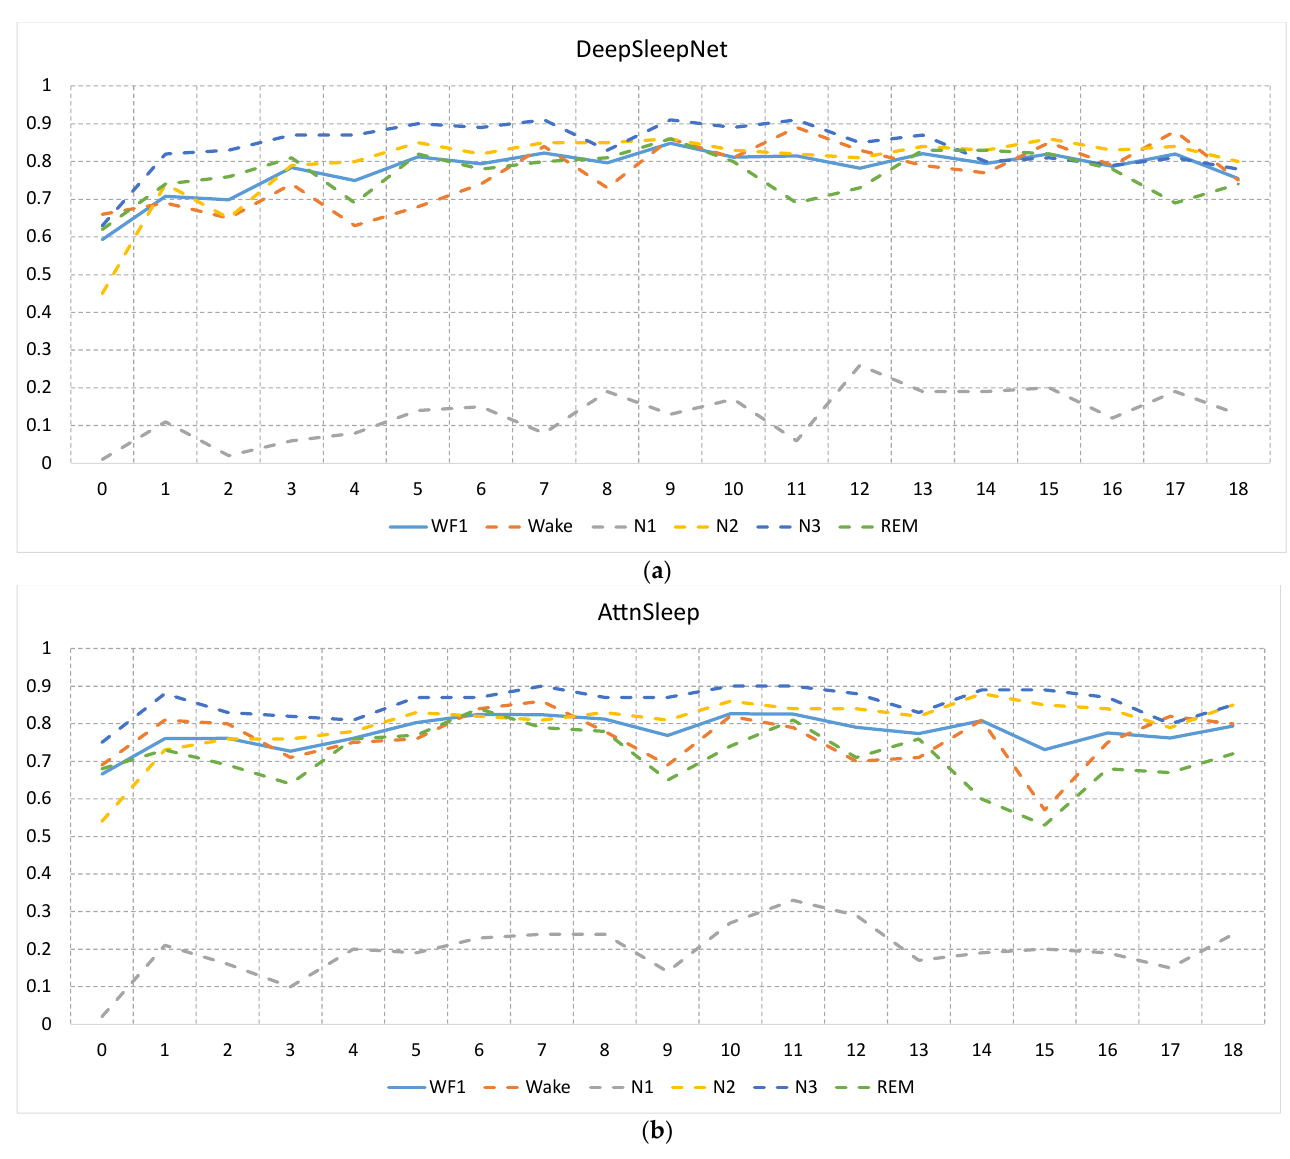
Figure 7. The F1 scores of the five sleep stages (dotted lines) over all age groups along with the WF1 score (solid line) for ( a ) DeepSleepNet and ( b ) AttnSleep. As seen, a noticeable degradation in the performance was occurred in infant participants (age group 0) in the classification of all stages.